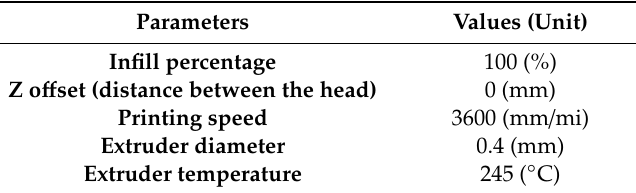
Table 5. Surface tensions of water and α -bromonaphthalene.